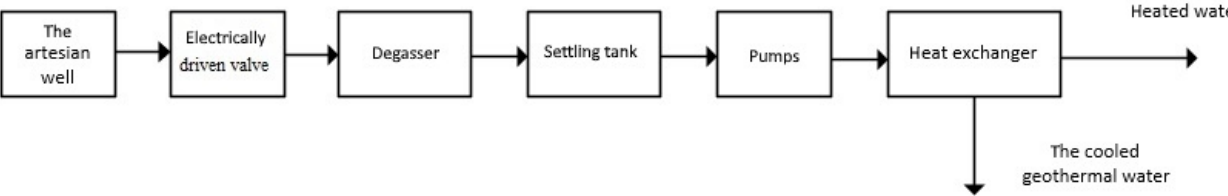
Figure 3. Functional diagram of the primary circuit of the heat exchanger of a heat supply system without an acoustic– magnetic device.